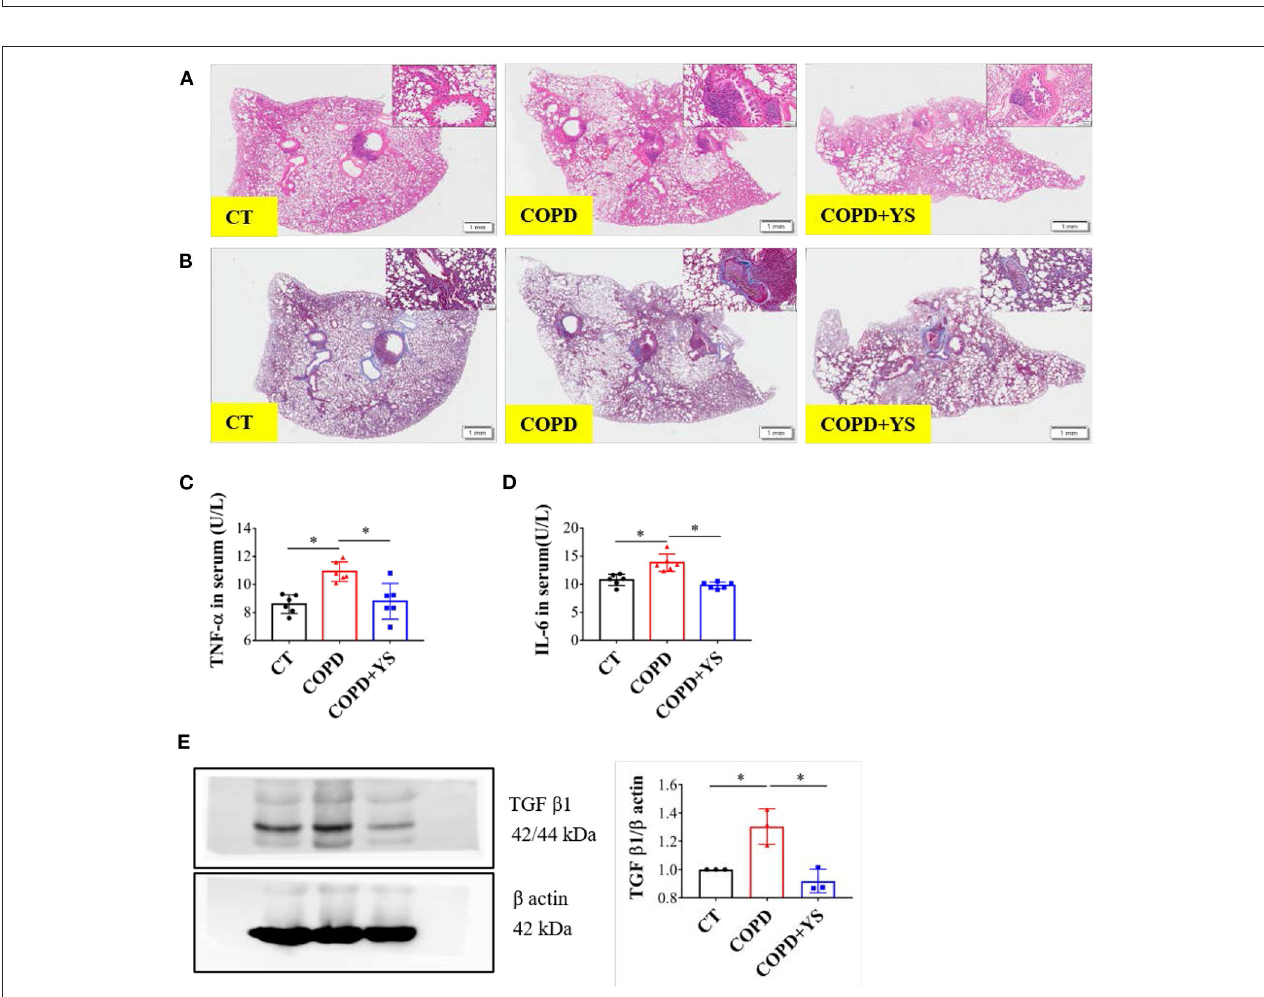
expression was lower in the lung ( P > 0.05), caspase-1 and ASC were lower in lung tissue ( P > 0.05), and IL-18 levels of serum were significantly lower ( P < 0.05). These results